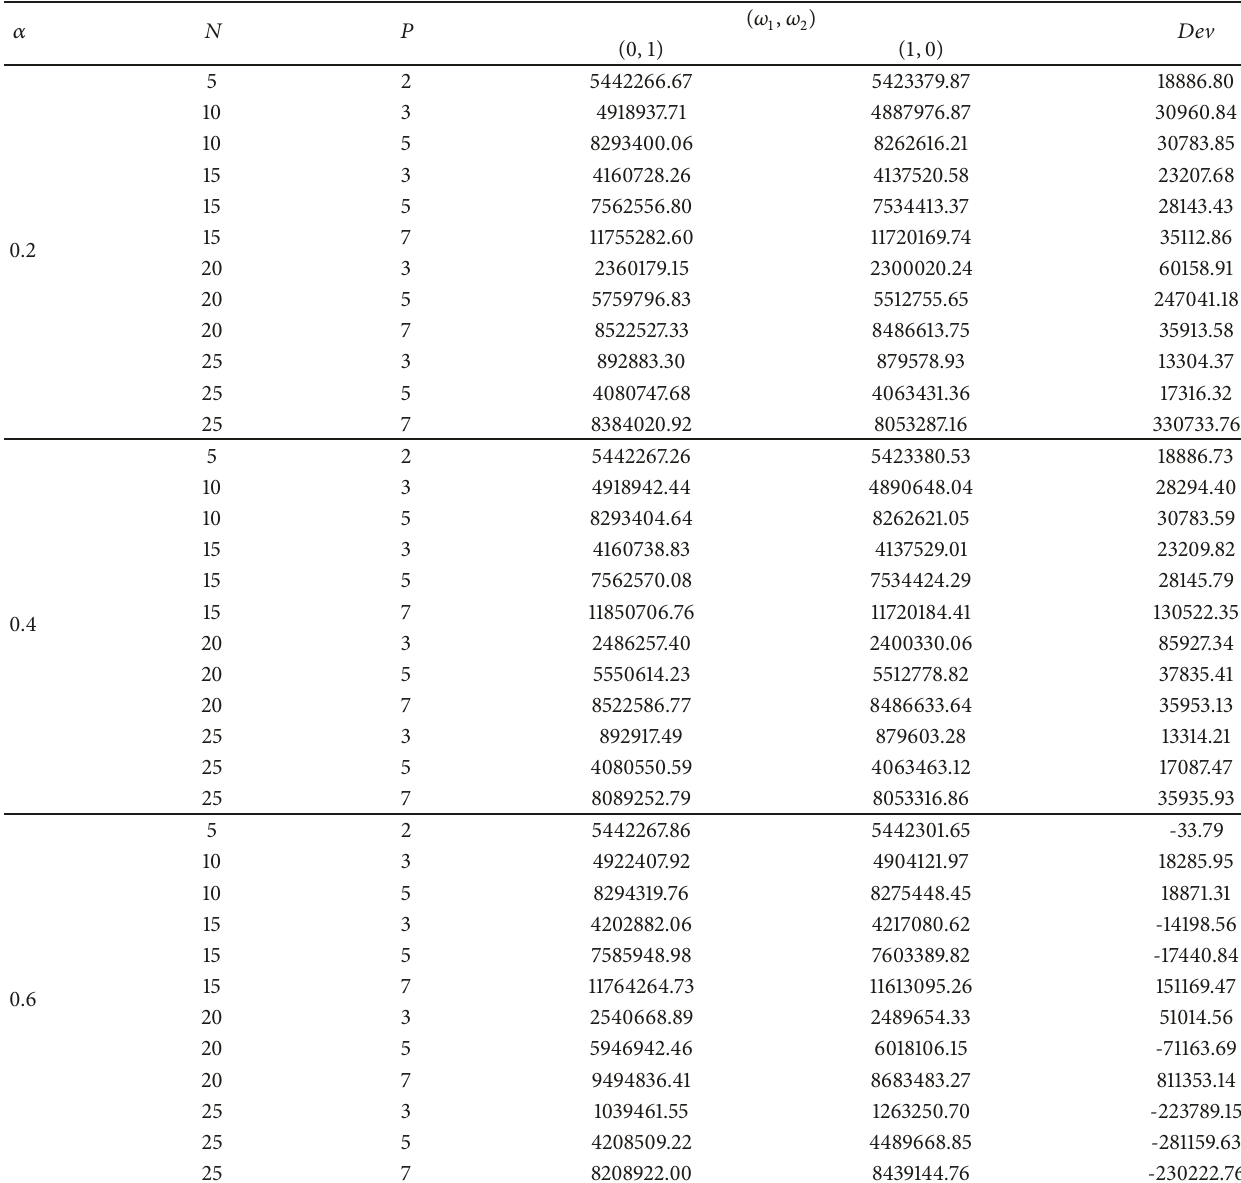
Table 1: Profits under (0, 1) and (1, 0)